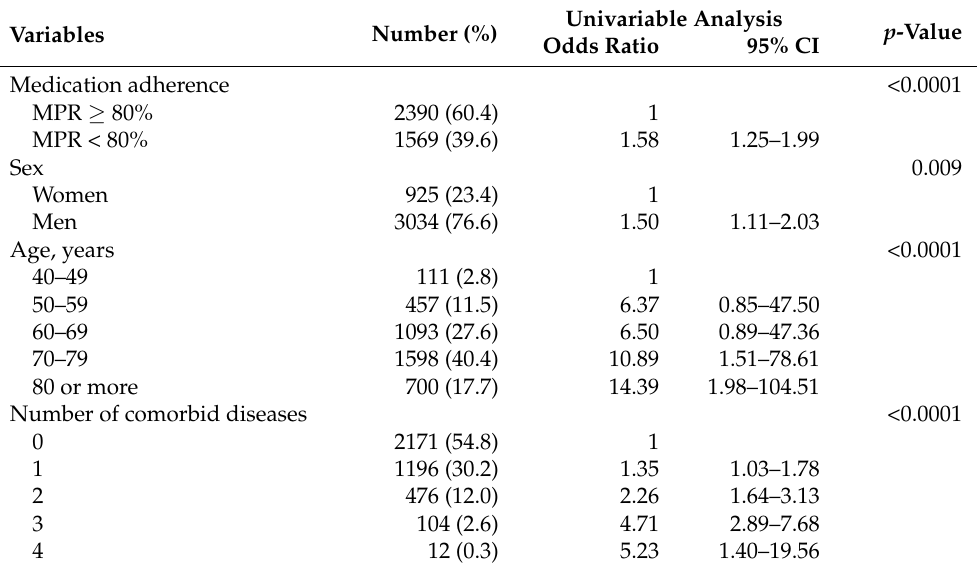
Table 3. Risk factors contributing to acute exacerbation in patients with COPD during